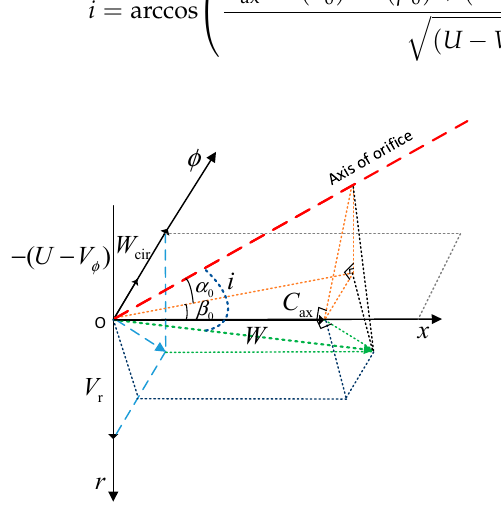
Figure 3. Definition of the comprehensive incidence angle.